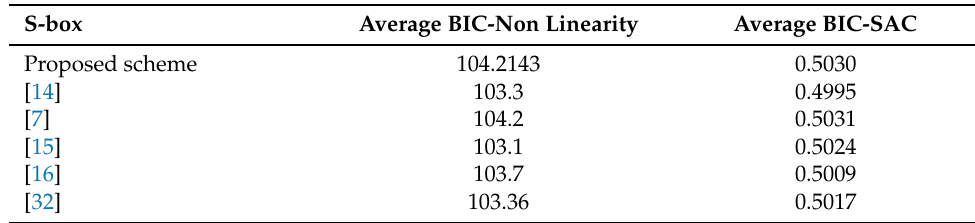
Table 8. Comparison of BIC.